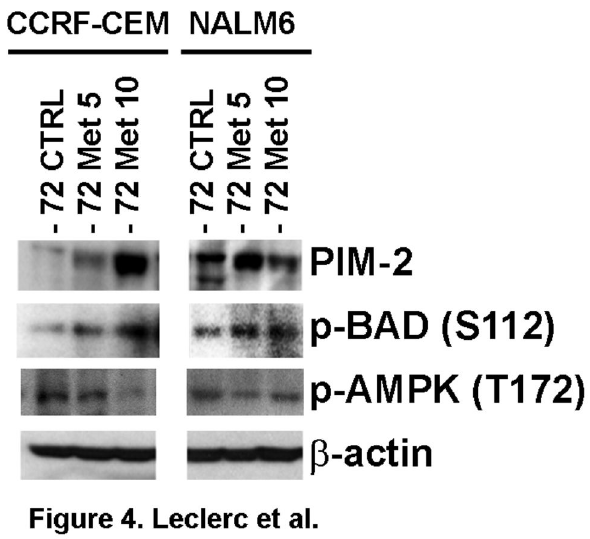
Figure 4. Metformin induces expression of PIM-2 in ALL cells. Western blot analysis of PIM-2, p-BAD (S112) and p- AMPK (T172) expression in CCRF-CEM and NALM6 cells treated with metformin (MET, 5 and 10 mM) for 72 h at